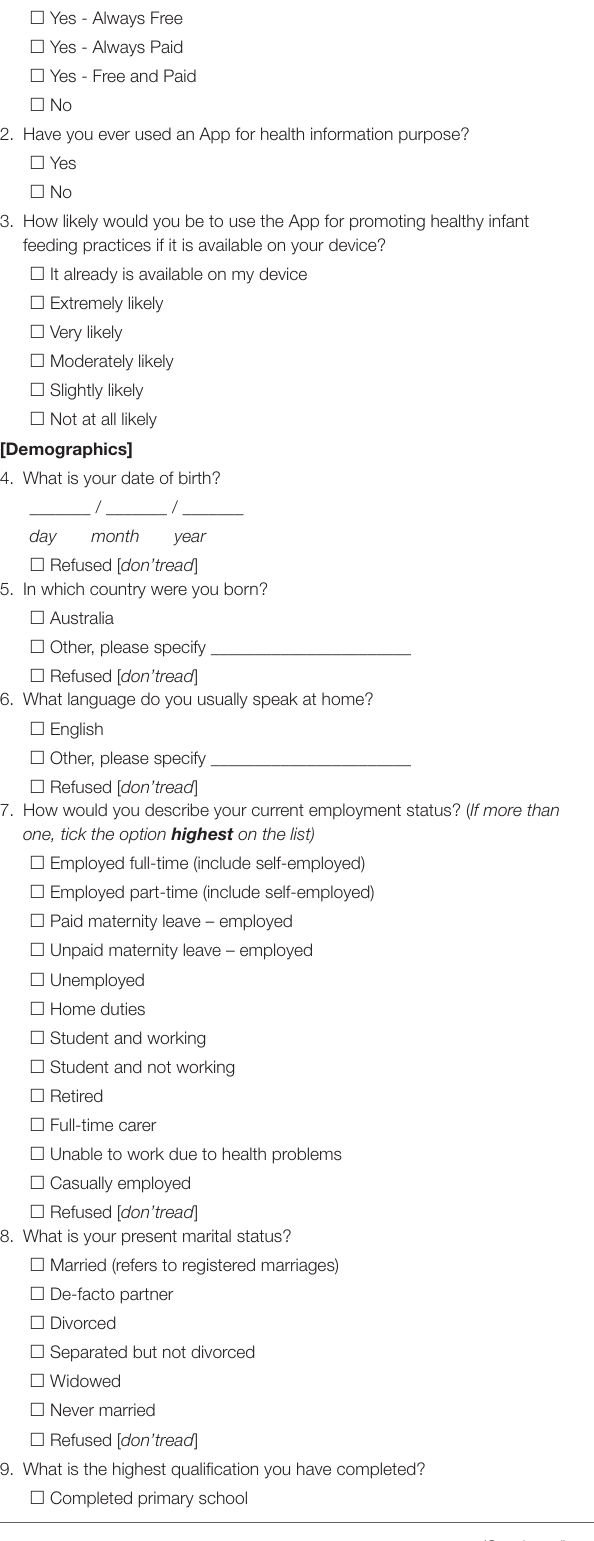
TABLE 1 | Study 1: survey questions used in the cross-sectional